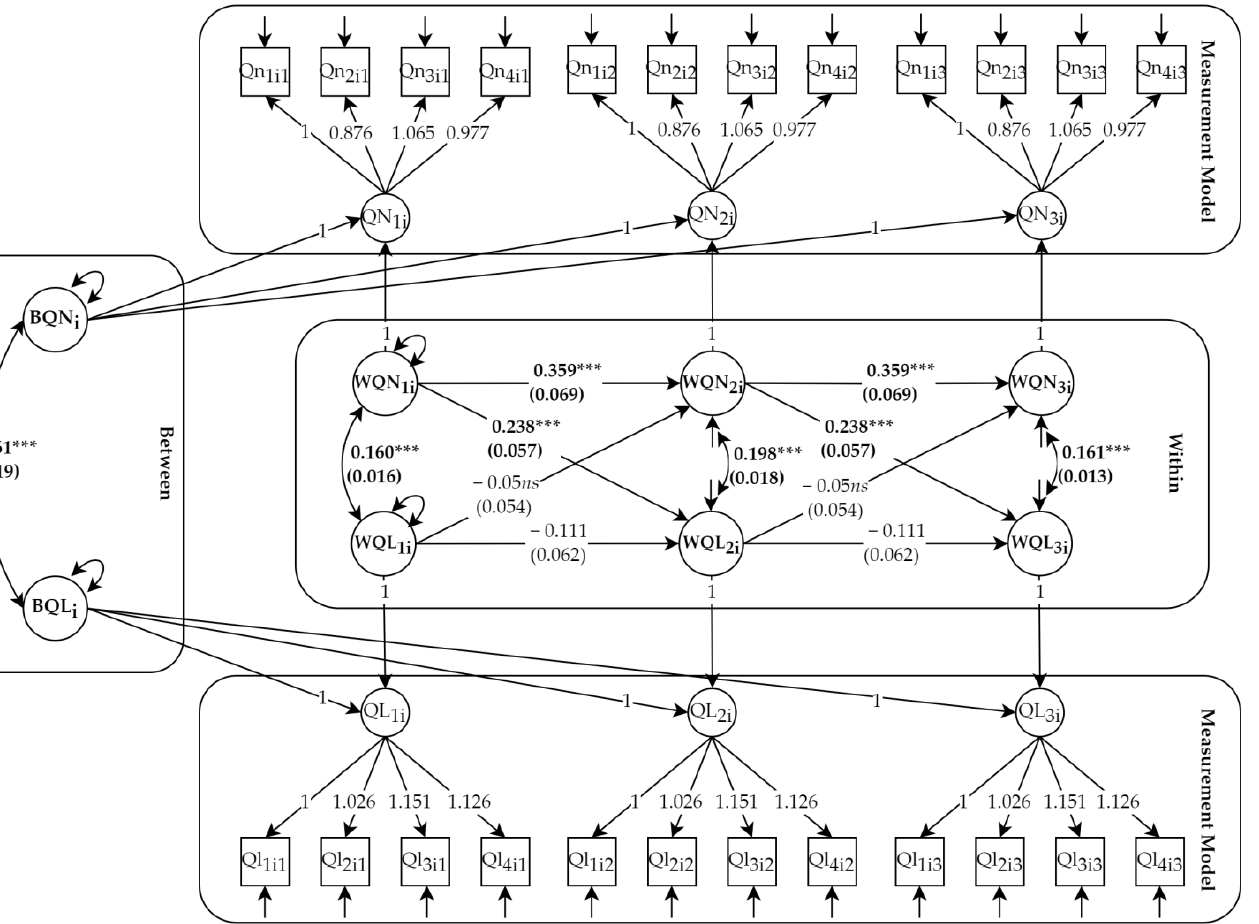
Figure 1. The results of the random-intercepts cross-lagged panel model with standardised path coefficients. Note: *** p < 0.001; QNti—latent quantitative job insecurity; QLti—latent qualitative job insecurity; BQNi—random intercept for quantitative job insecurity; BQLi—random intercept for qualitative job insecurity; WQNti—within-person fluctuations in quantitative job insecurity; WQLti—within-person fluctuations in qualitative job insecurity. The graphical representation of the research model is based on the article by Mulder and Hamaker